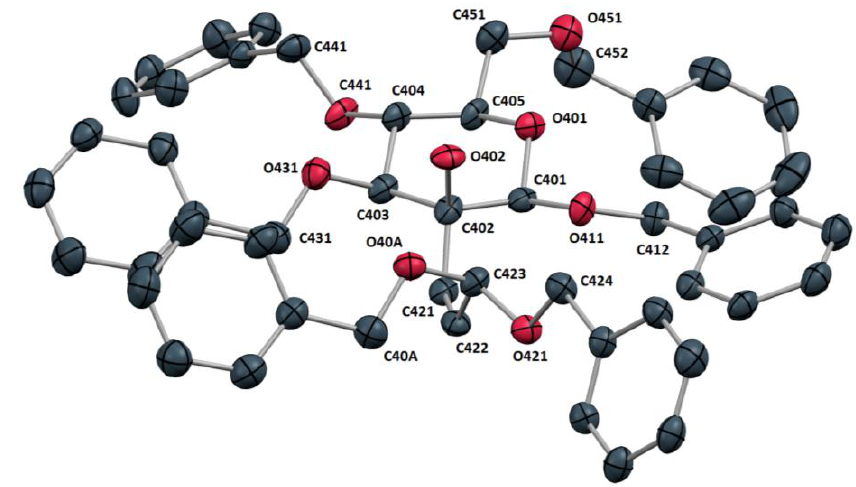
Figure 3. Molecular structure of 4a . Hydrogen atoms are omitted for clarity. Ellipsoids are drawn at a 50% probability level. Red = oxygen, gray = carbon.